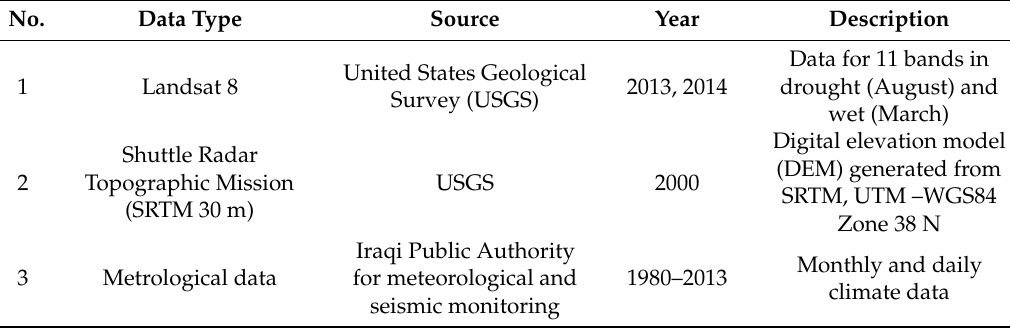
Table 1. The data type, source, year, and description.